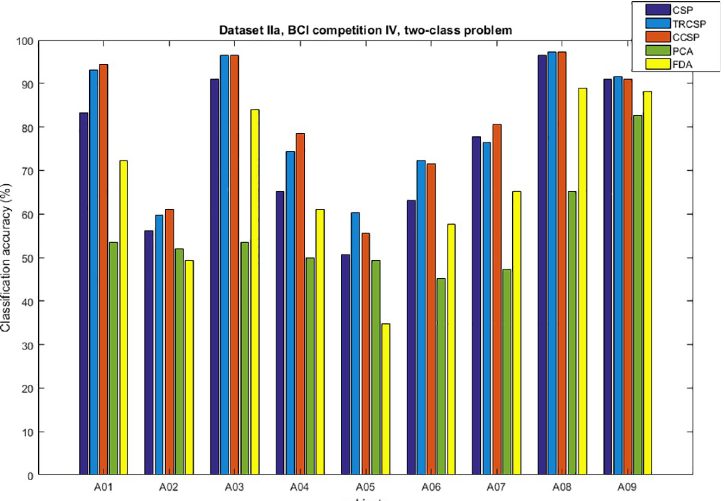
Fig 3. Comparison between classification accuracy of methods for two-class problem in dataset IIa, BCI competition IV.